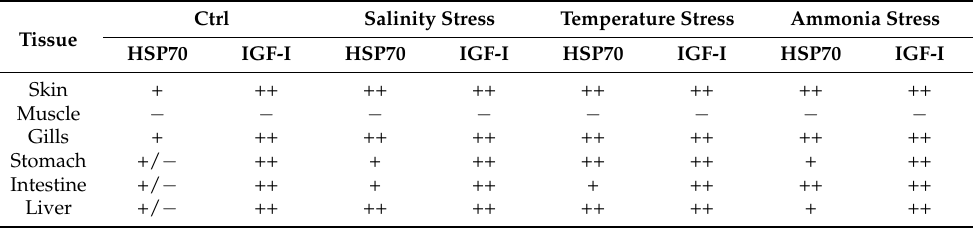
Table 2. Immunohistochemical localizations of HSP70 and IGF-I in different tissues of Sparus aurata (control and stressed animals): − , not detectable; +/ − , slight but above background levels; +, moderate staining; ++ marked